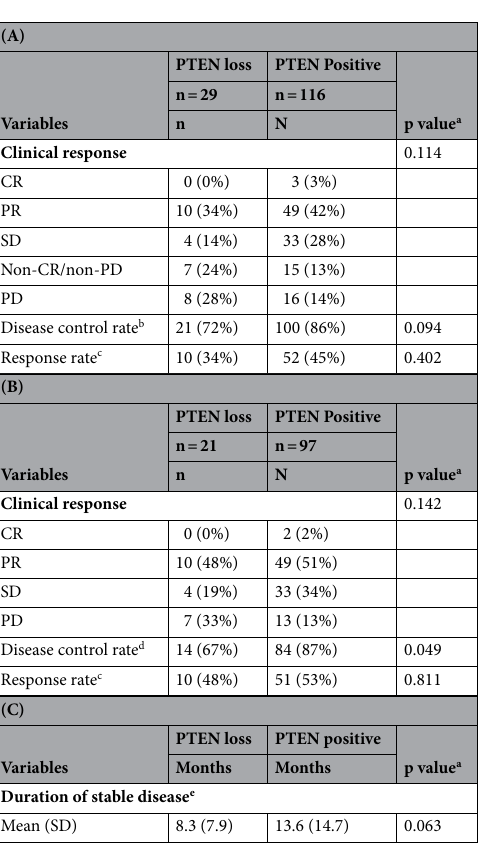
Table 3. Clinical response to trastuzumab combined chemotherapy. (A). Objective response rate and disease control rate in 145 patients. (B). Objective response rate and disease control rate in 118 patients with target lesions. (C). Duration of stable disease. CR complete response, PR partial response, SD stable disease, PD progressive disease. a Fisher extract test was used for categorical items and Student’s t test was used for continuous variables, respectively. b Disease control rate: the sum of the proportion of CR and PR and SD and non-CR/non-PD in (A). c Response rate: the proportion of complete response and partial response in (A) and (B). d Disease control rate: the sum of the proportion of CR and PR and SD in (B). e Duration of stable disease: the duration from the date when trastuzumab-combined therapy was first administered to the date when PD was